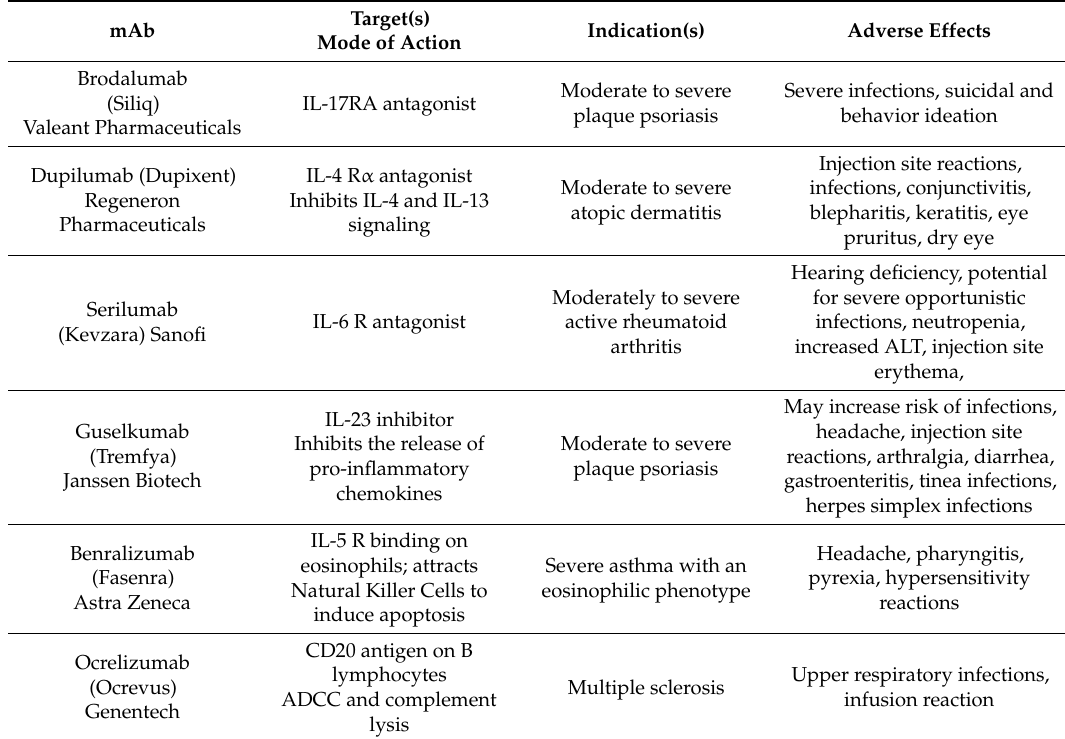
Table 1. USFDA mAb Approvals in